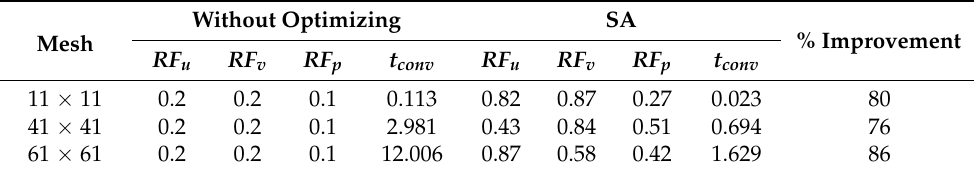
Table 10. Comparison of the convergence times obtained from the driven-cavity problem, applying the relaxation factors obtained with SA vs. RF not optimized, with different mesh sizes and a relaxed residual value of ε = 1 × 10 − 5 .